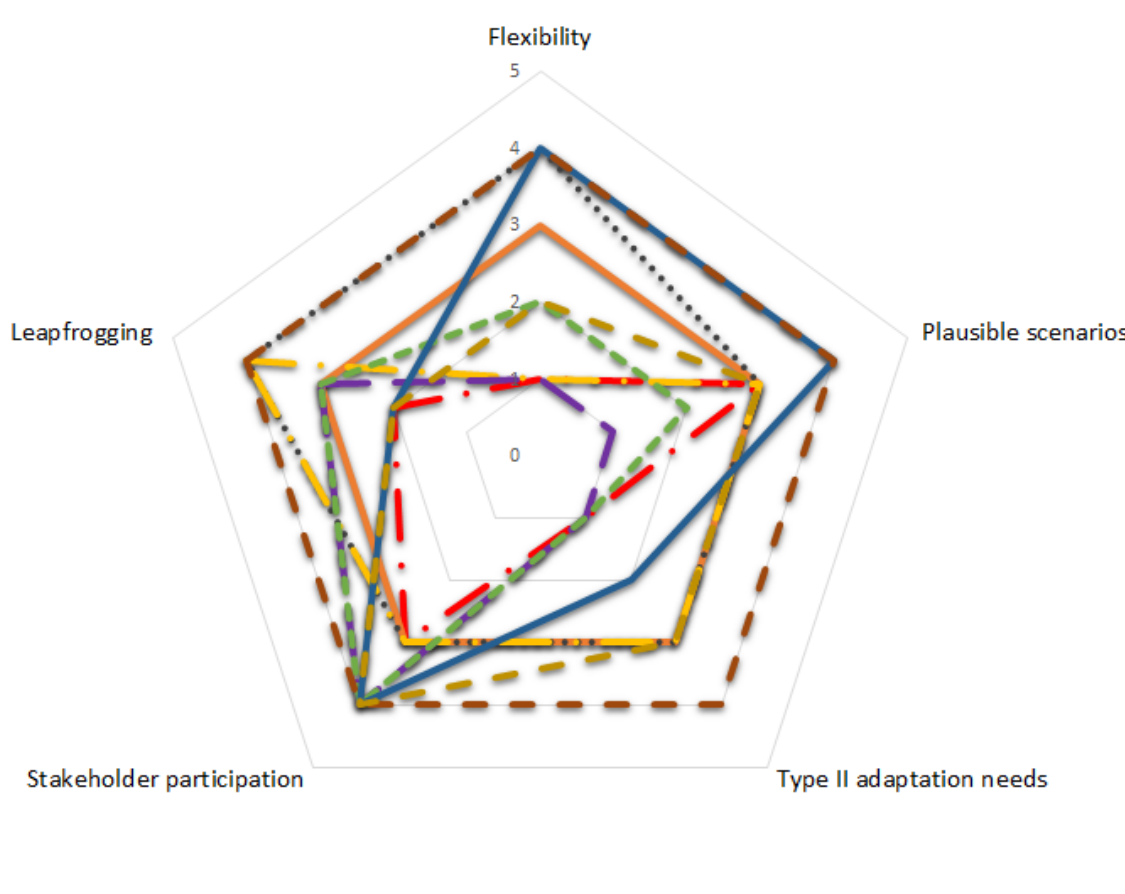
Figure 10. Agility score card for adaptation responses.